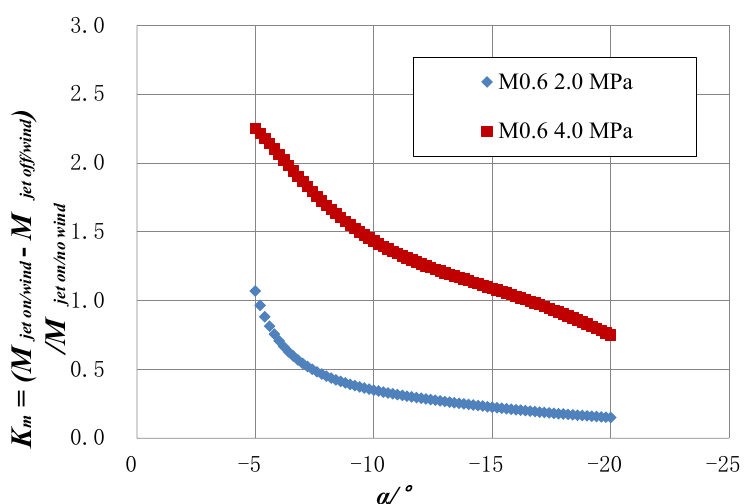
Figure 19. Curves of K M vs. angle of attack at M = 0.6, jet on 2.0 and 4.0 MPa.